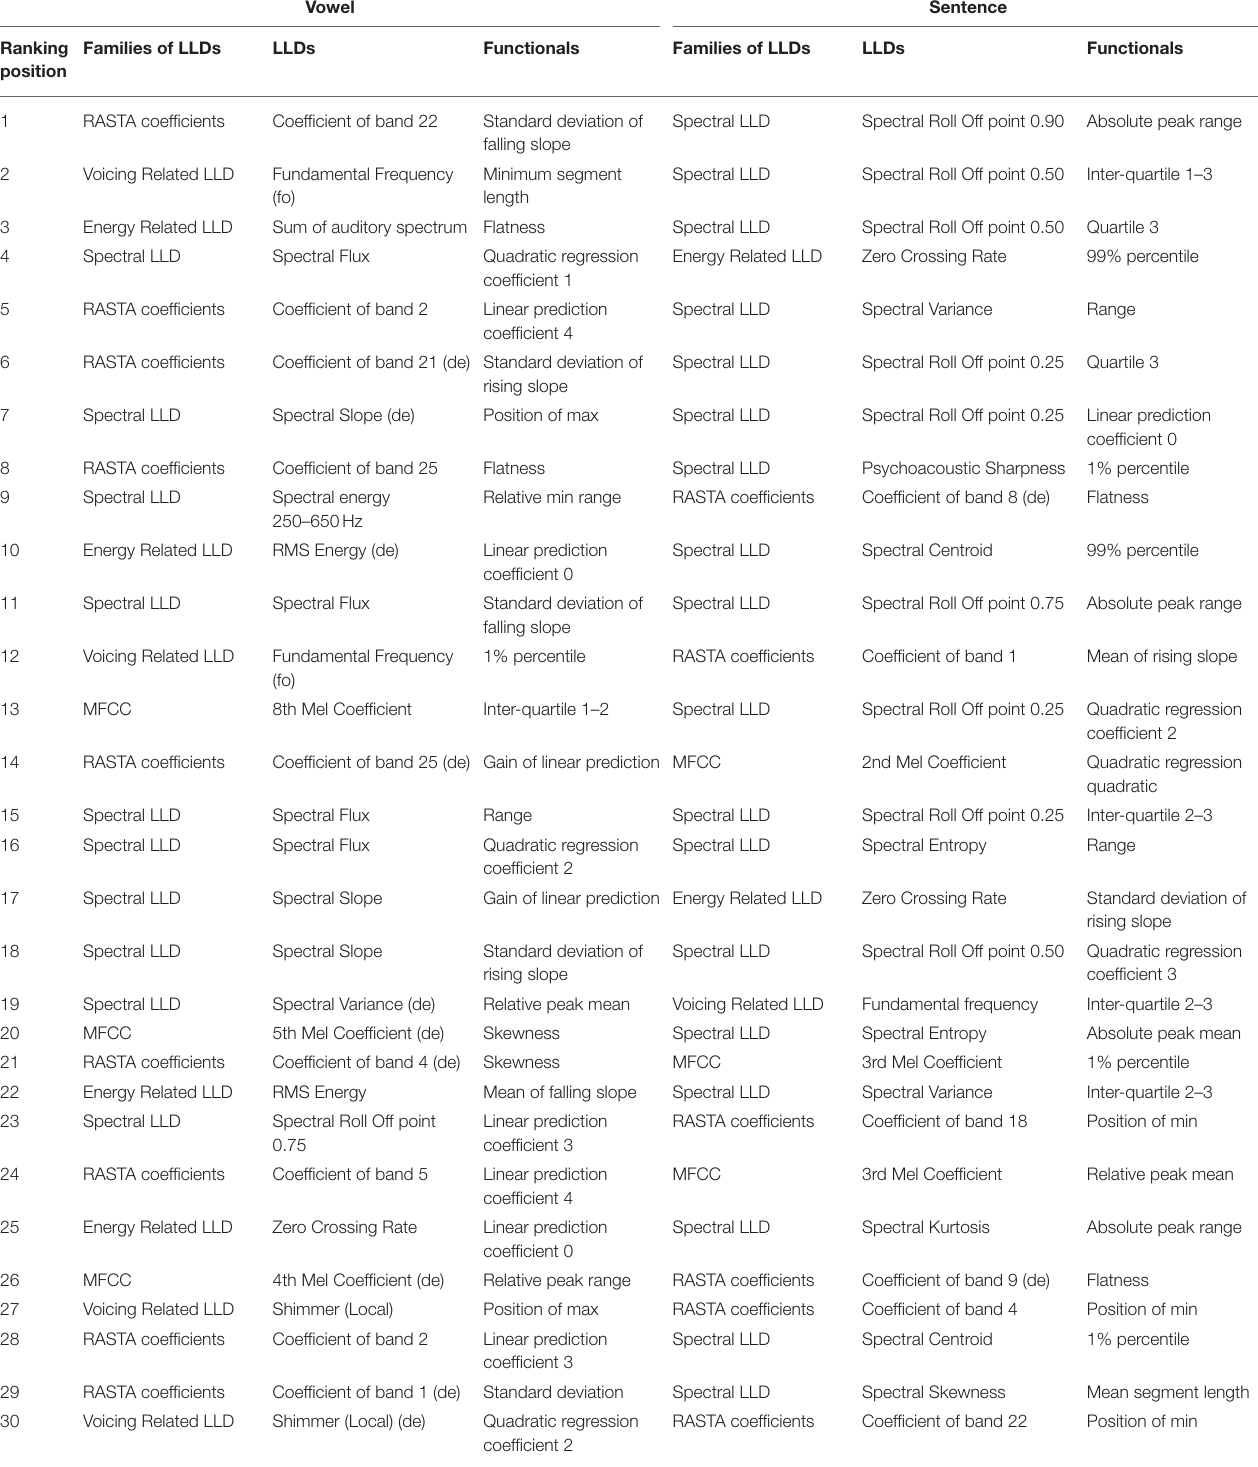
The table refers to selected voice features for the comparison between healthy subjects and patients with Parkinson’s disease. Ranking of the first 30 features (functionals applied to low-level descriptors—LLDs) extracted using a dedicated software (OpenSMILE) and selected using Information Gain Attribute Evaluation (IGAE) algorithm for the comparison between healthy subjects and the whole group of patients with PD, during the sustained emission of the vowel and sentence. MFCC, mel-frequency cepstral coefficient; de, first derivative of the LLD.